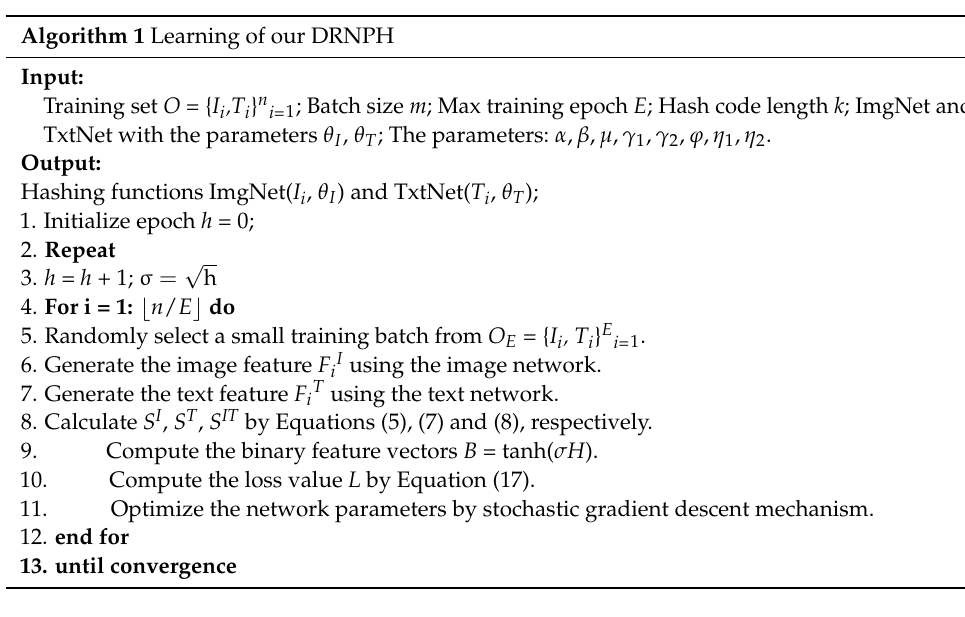
Algorithm 1 Learning of our